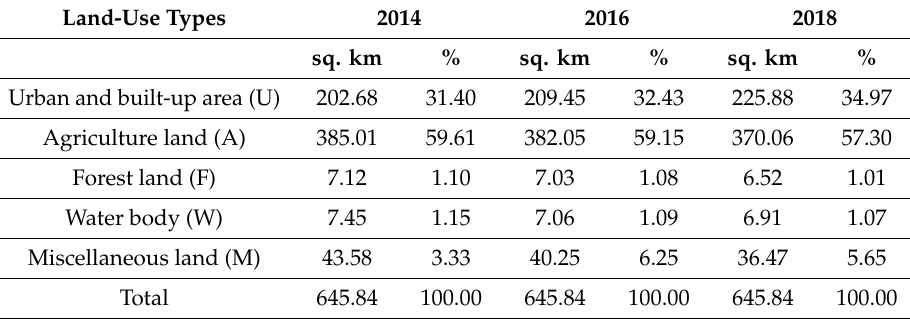
Table A1. Allocation for land-use categories in 2014, 2016, and 2018.